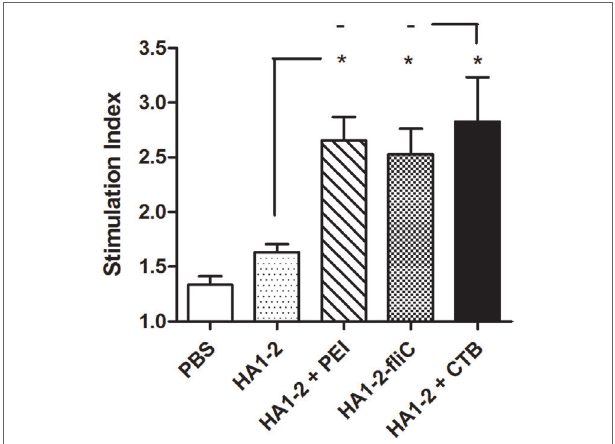
FigUre 5 | splenocyte stimulation index (si) . Splenocytes were prepared from the spleens of mice after the third immunization, and the SI of cells in response to purified HA1–2 (10 μ g/ml) protein was calculated based on cell proliferation, as determined with the BrdU assay, using the following equation: SI = (OD 450 − OD 690 of antigen-treated cells)/(OD 450 − OD 690 of untreated cells).